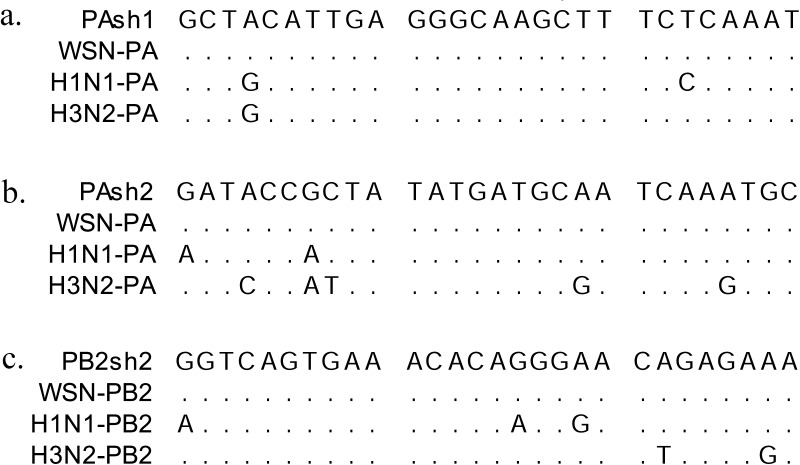
Alignment of the shRNAs sequences with two clinical trains (seasonal H1N1 and H3N2).We employed two clinical strains of influenza virus (seasonal H1N1 and H3N2) and aligned the targeted sequences with the shRNAs. The shRNA sequences do not perfectly match the two clinical strains.